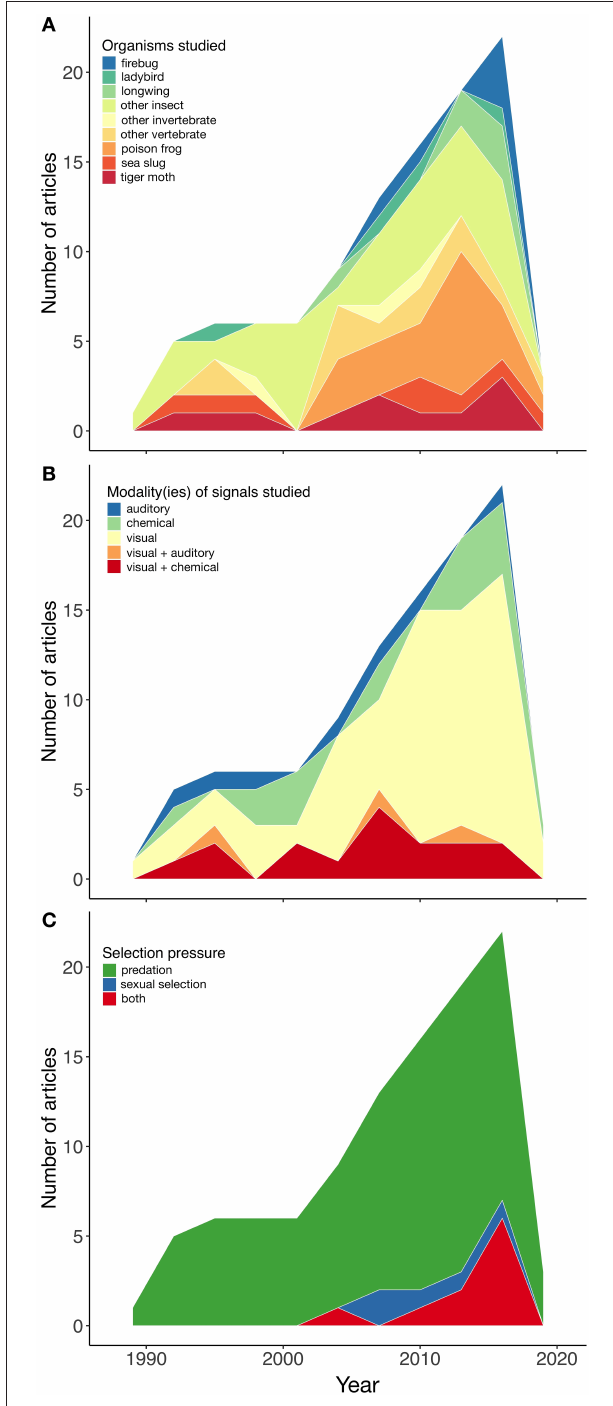
FIGURE 6 | (A) Representative animal groups studied in relation to aposematism over the last three decades. The larger the area, the more studies on that particular group. (B) Signaling modalities studied in relation to aposematism over the last three decades. The larger the area, the more studied. (C) Selection pressures taken into account in studies on aposematism over the last three decades. The larger the area, the more studies taking that particular selective pressure into